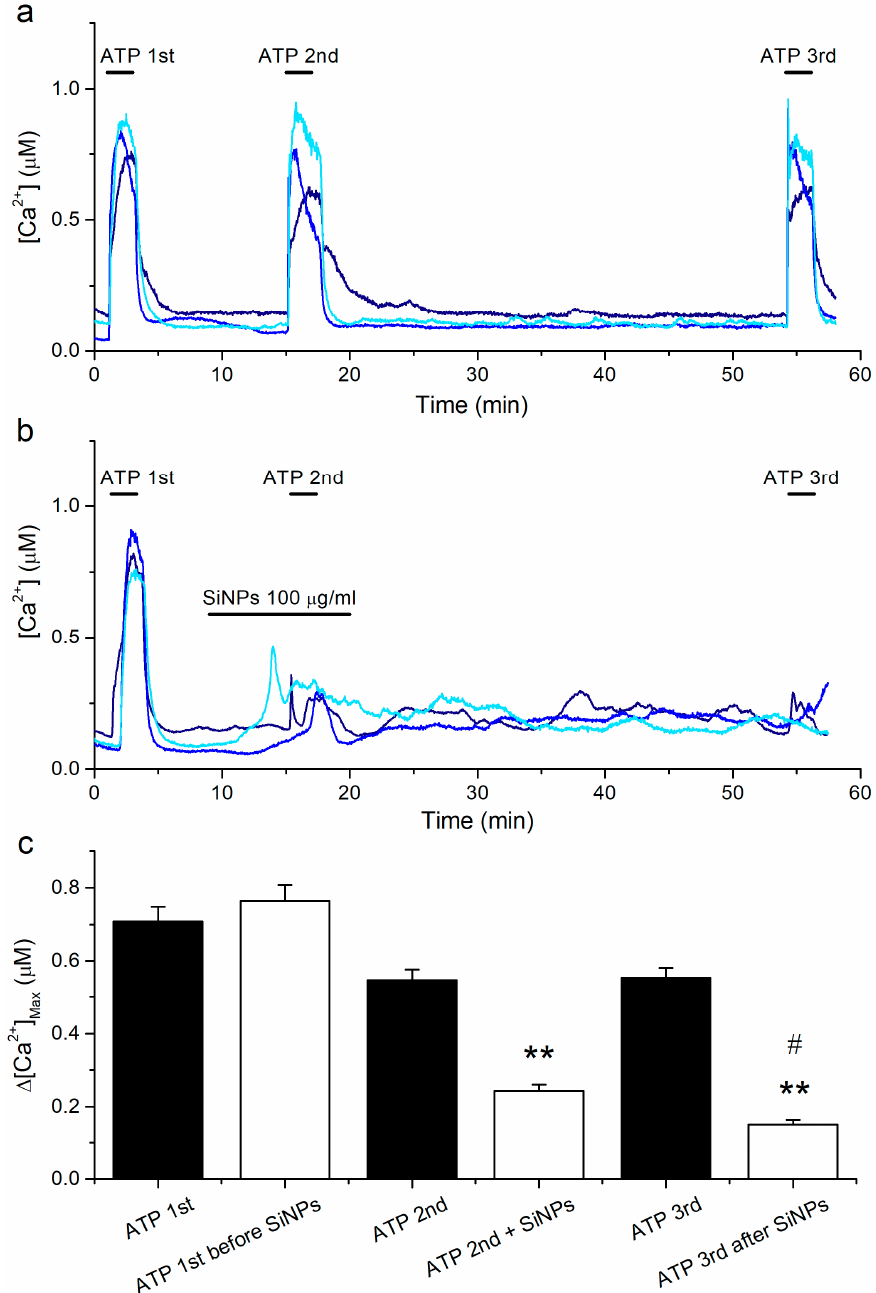
Figure 4. Persistent inhibitory action of SiNPs on responses to ATP. ( a ) Examples of intracellular [Ca 2+ ] traces showing the effects of extracellular ATP applied at 10 μ M. ( b ) Examples of intracellular [Ca 2+ ] traces showing the effects of SiNPs when applied at 100 μ g/mL, before and during a second application of 10 μ M ATP. ( c ) Amplitude of the responses to three consecutive applications of ATP for the control series of experiments (black bars, n = 164) and for a series of experiments in which 100 μ g/mL SiNPs was applied 9 min before and during the second application of ATP (white bars, n = 140). The data are represented as mean ± s.e.m. The asterisks (**) denote statistically significant difference of the data obtained in SiNPs with respect to the corresponding control data in the absence of SiNPs ( p < 0.01; Kolmogorov–Smirnov test). The # symbol denotes statistically significant difference between ATP2nd + SiNPs and ATP3rd after SiNPs ( p < 0.01; Kolmogorov–Smirnov test).